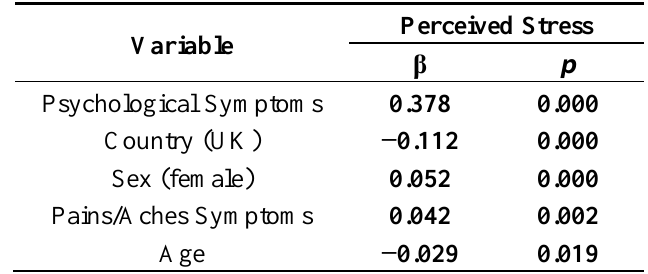
Table 8. Significant predictors of perceived stress among university students in the UK and Egypt together.